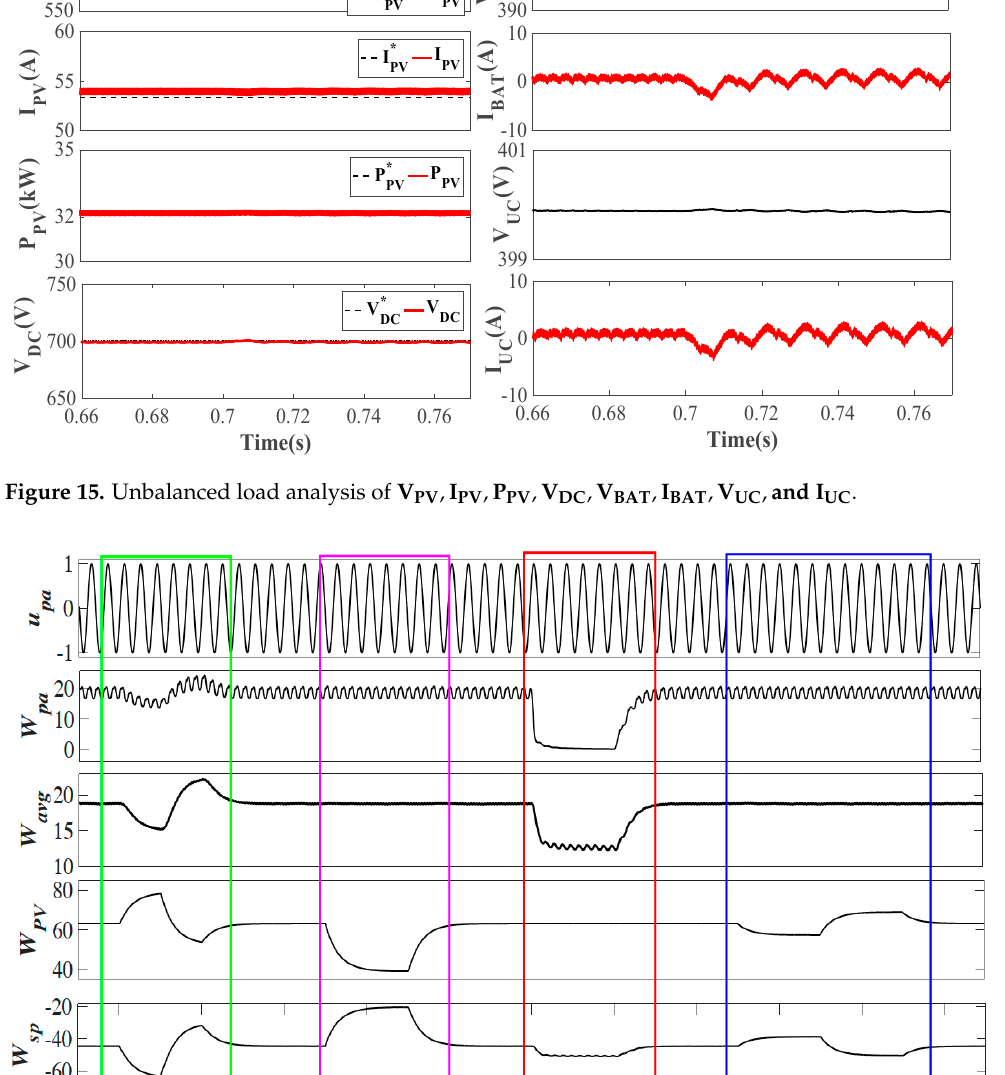
Figure 17. Comparison of (cid:2205) (cid:2183)(cid:2204)(cid:2189) with LMS, LMF, MCC, AKWMCC and MRFKMP-based VSC control. The LMS delivers high steady-state error as compared to LMF. The MCC and AKWMCC present almost similar weights; AKWMCC shows fewer variations as com- pared to MCC during steady-state and dynamic conditions. The MRFKMP-based VSC control delivers the more accurate weight signals with reduced variations during abnor- mal grid voltage and load unbalancing, and it results in reduced overall losses in the sys- tem and provides better efficiency. The comparative analysis of the proposed control with LMS, LMF, MCC, AKWMCC and MRFKMP is shown in Table 2. 0